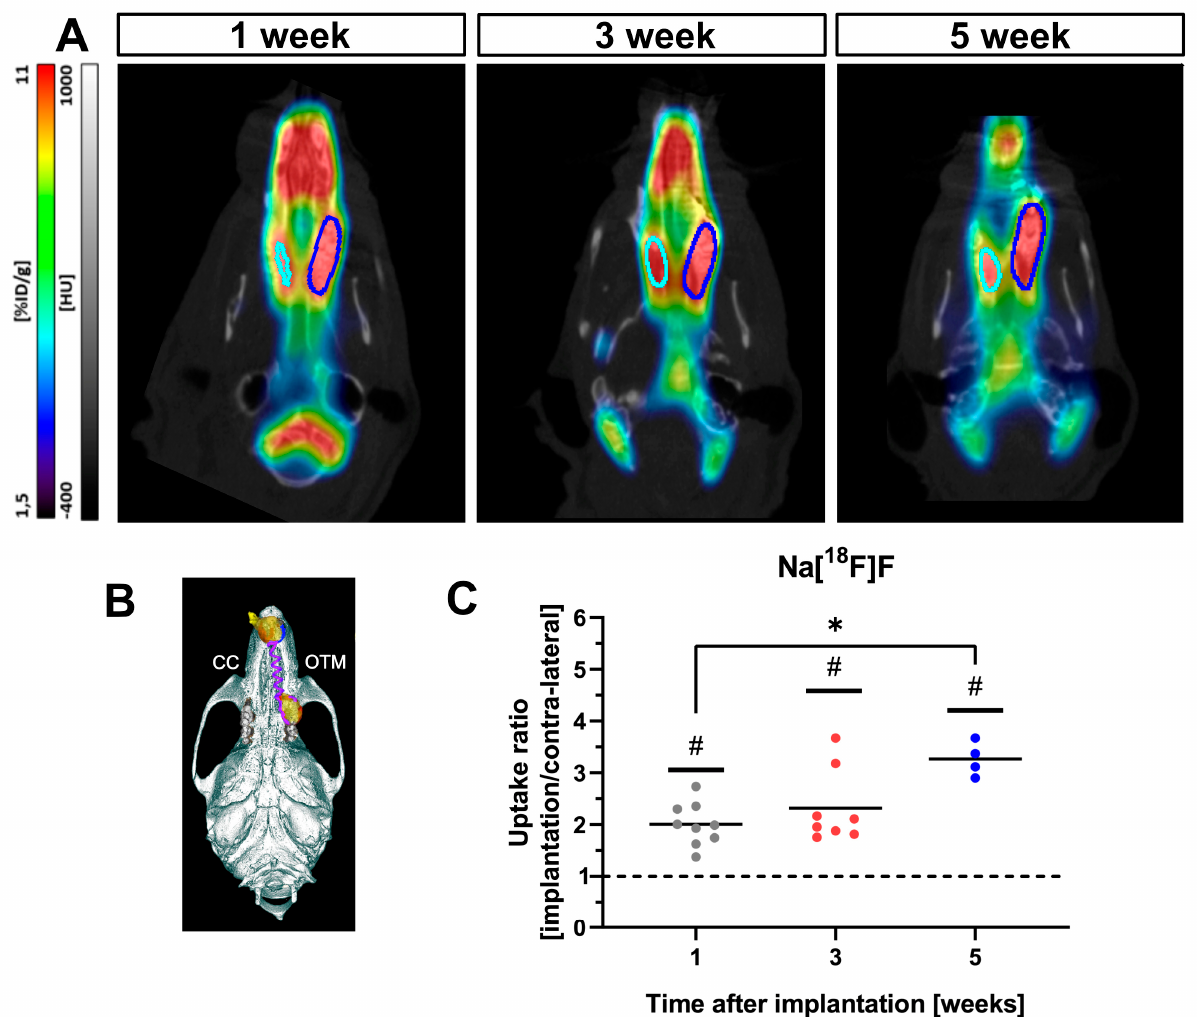
Figure 2. Na[ 18 F]F longitudinal uptake. ( A ) Na[ 18 F]F uptake increases in the region of interest (left superior molar region, under orthodontic tooth movement) compared to the contralateral side, which was taken as a reference for background uptake. The deep-blue contour represents the region of interest taken for the OTM side, while the turquoise one represents the contralateral side of the jaw, which was taken as a control. ( B ) OTM and control (CC) sides as revealed by the 3D rendering of the CT scan. ( C ) Significant differences compared to 1 were visible in all scanning weeks, with significant difference between the 1st and the 5th week as well. *: statistically significant difference compared to 1st week, #: statistically significant difference compared to 1.0.